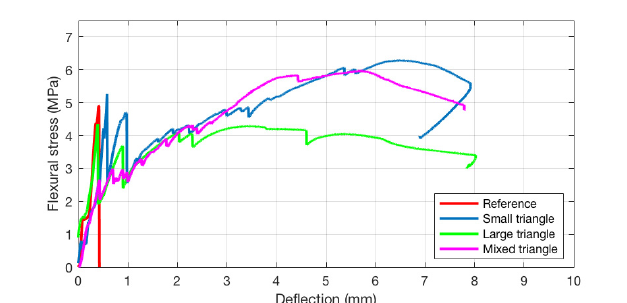
Figure 8. Flexural stress ‐ deflection curves for specimens tested after 7